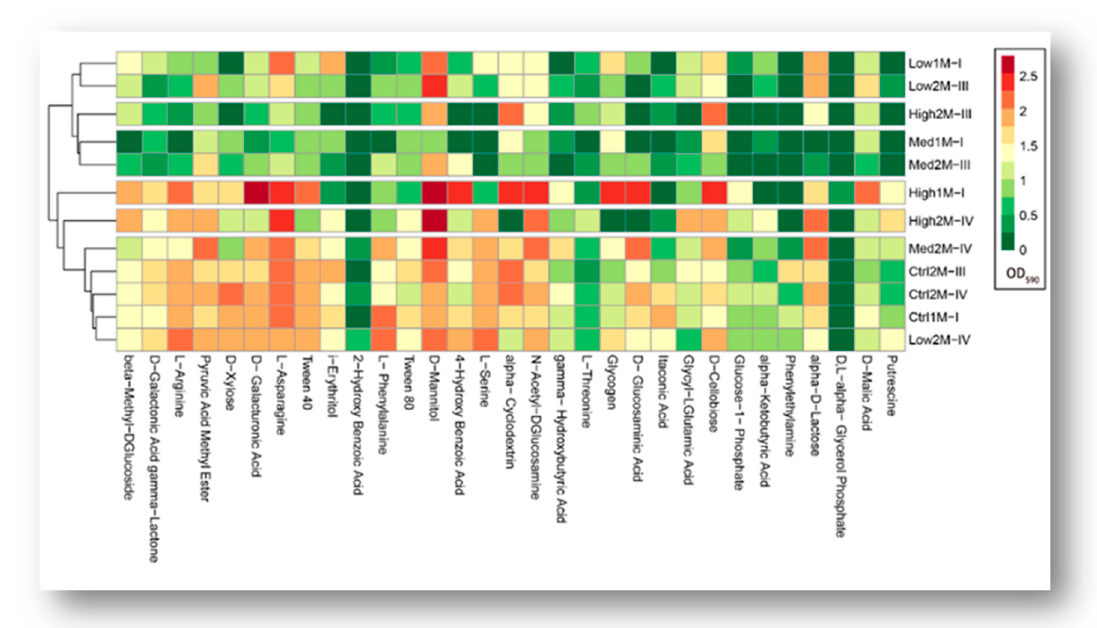
Figure 2. Average use of groups of carbon substrates based on readings in the 144 h of incubation. Ctrl, Low, Med, High — optimal moisture and low, medium and high water stress, respectively; 1M, 2M — month of the experiment; I, III, IV — sampling time.